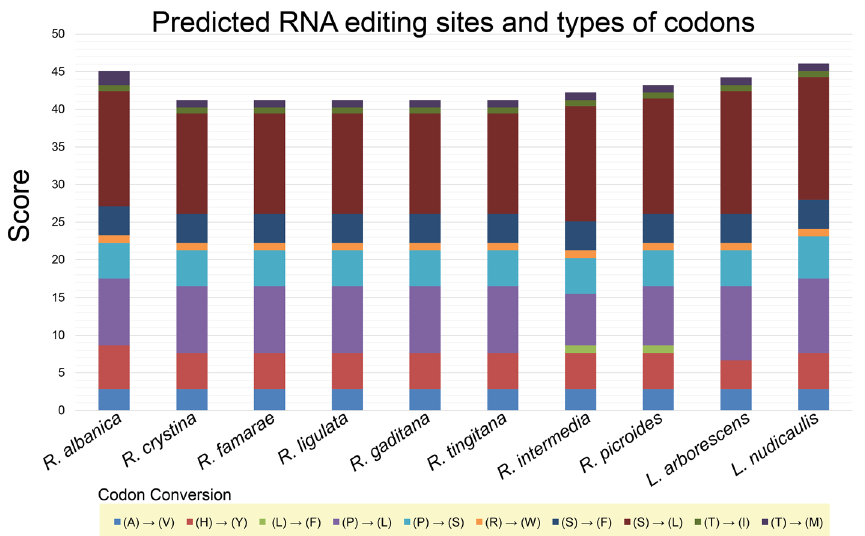
Figure 4. Amino acid changes in predicted RNA editing sites in ten chloroplast genomes of eight Reichardia and two Launaea species. The scores (the proportion of sites that have the same amino acid at that position) of each edit site are stacked in each bar column. Color bricks indicate RNA editing effect: Alanine to Valine, A → V; Histidine to Tyrosine, H → Y; Leucine to Phenylalanine, L → F; Proline to Phenylalanine, P → F; Proline to Leucine, P → L; Proline to Serine, P → S; Arginine to Tryptophan, R → W; Serine to Phenylalanine, S → F; Serine to Leucine, S → L; Threonine to Iso-leucine, T → I; and Threonine to Methionine, T →